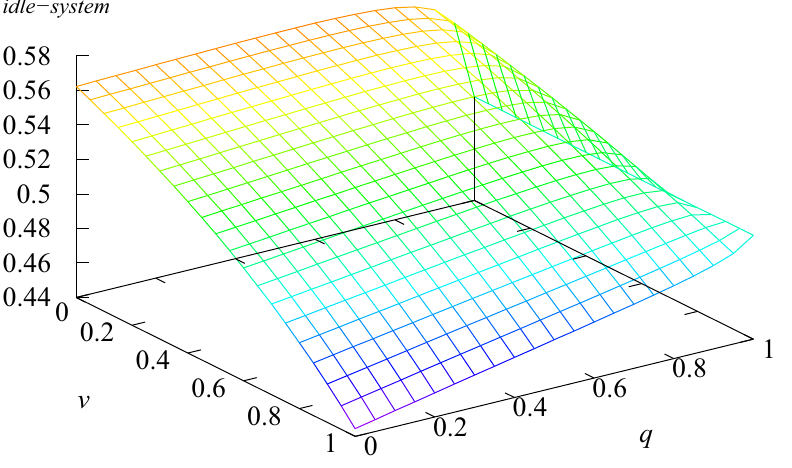
Figure 9. Dependence of the probability P idle − system that the system is idle at an arbitrary moment on the parameters q and ν .